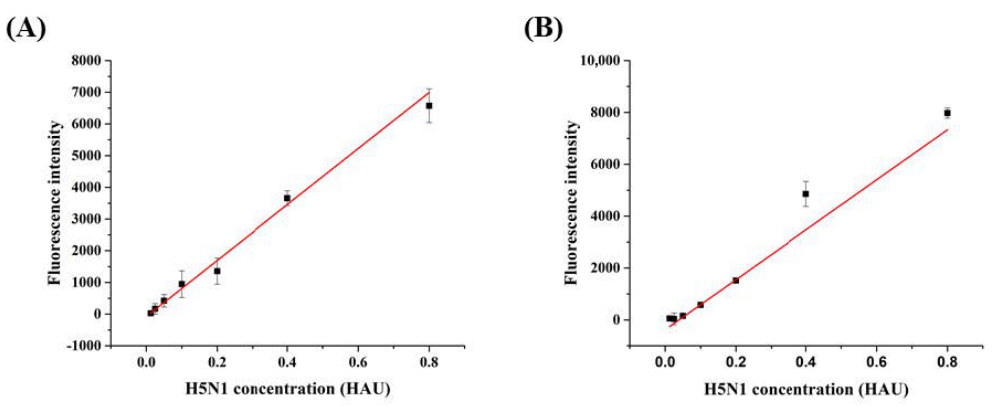
Figure 3. Limit of detection (LOD) for H5N1: ( A ) HBA1 LOD = 0.08 HAU, and ( B ) HBA2 LOD = 0.1 HAU.